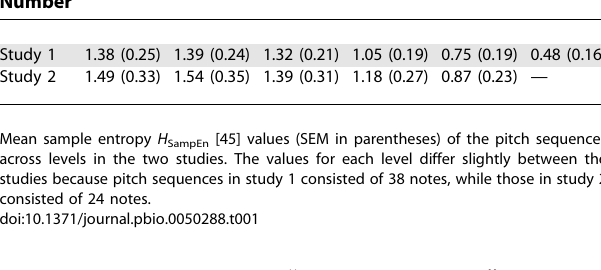
Table 1. Mean Entropy